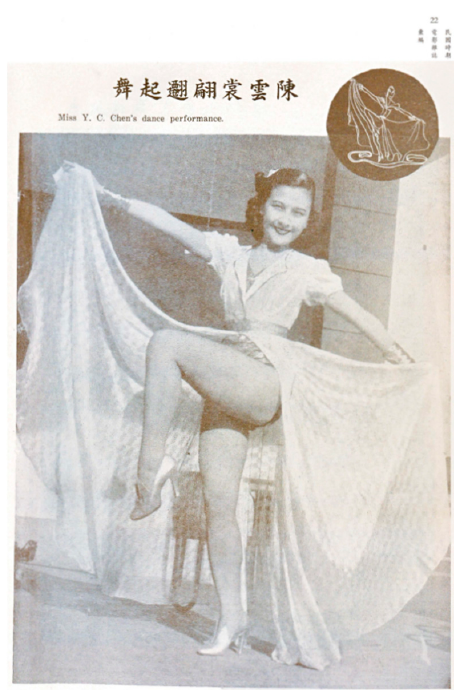
Figure 2. Film Still of Chen Yunshang as Mulan. ( Xinhua Pictorial, no.1, 1939).